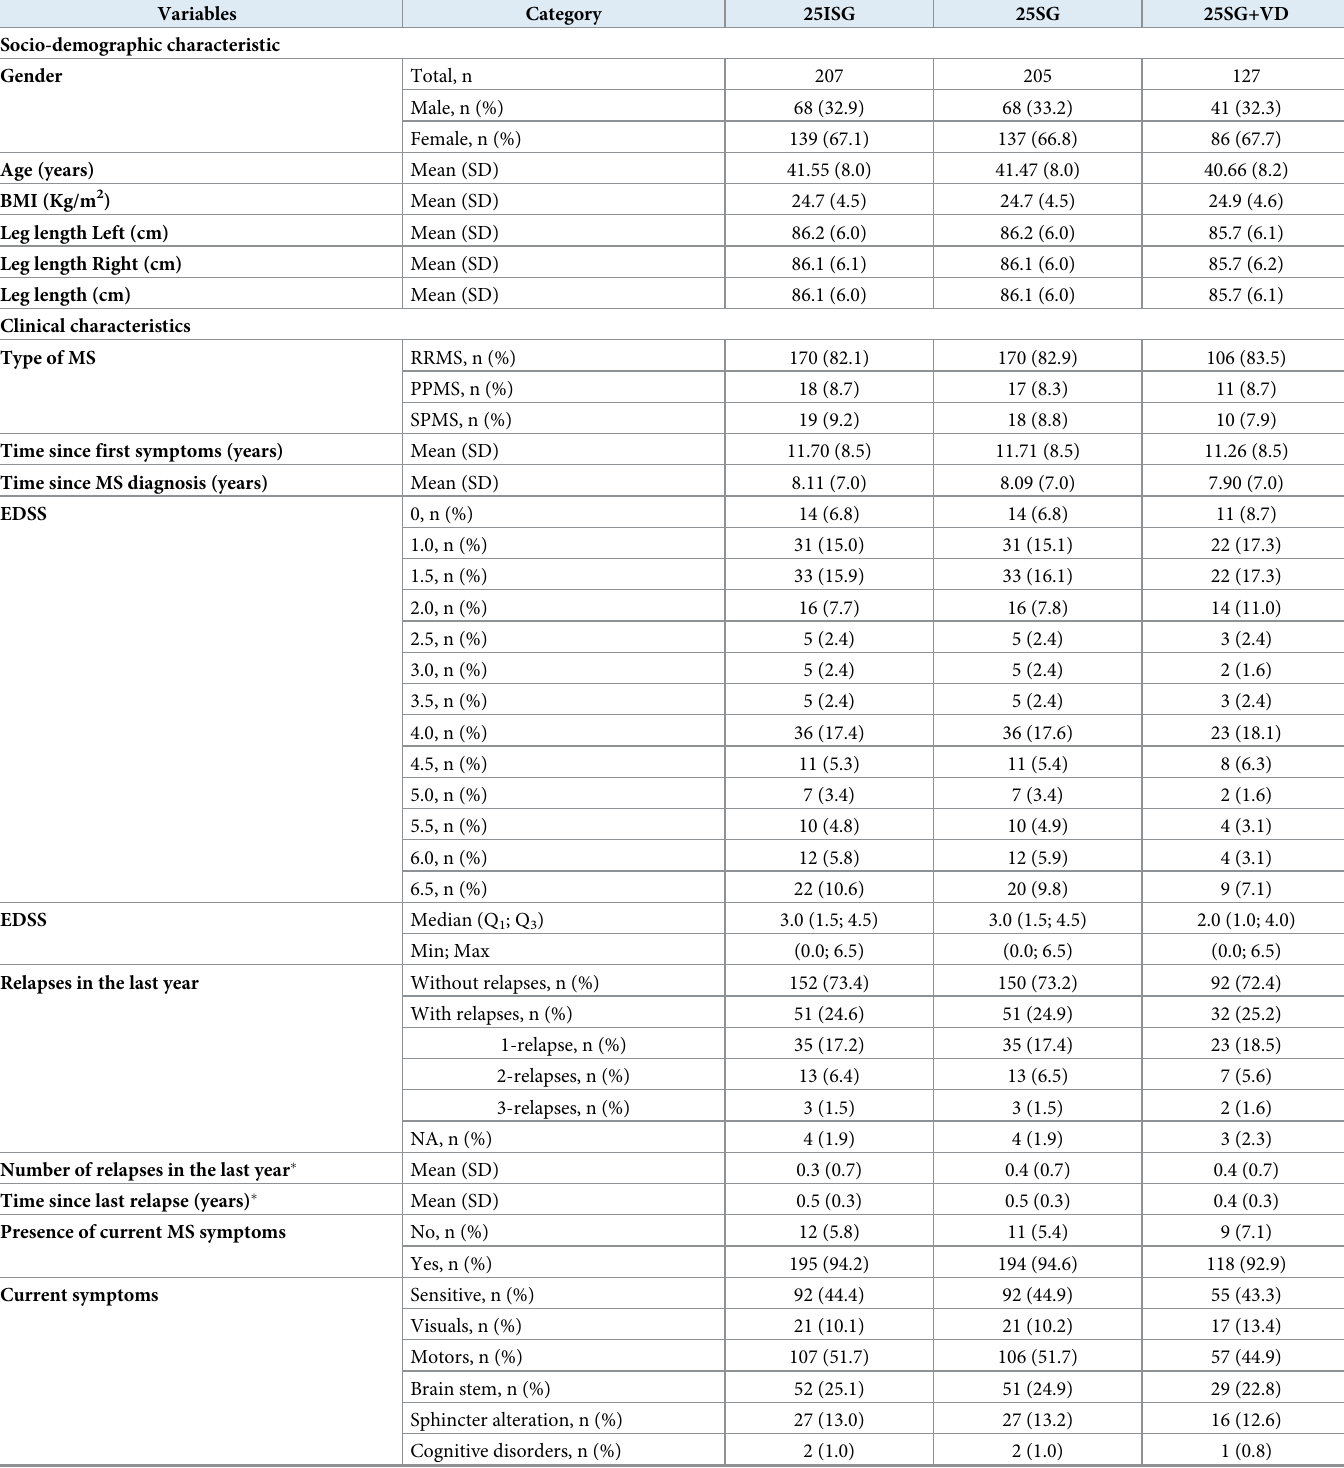
Table 2. Demographic and clinical characteristics of the different study